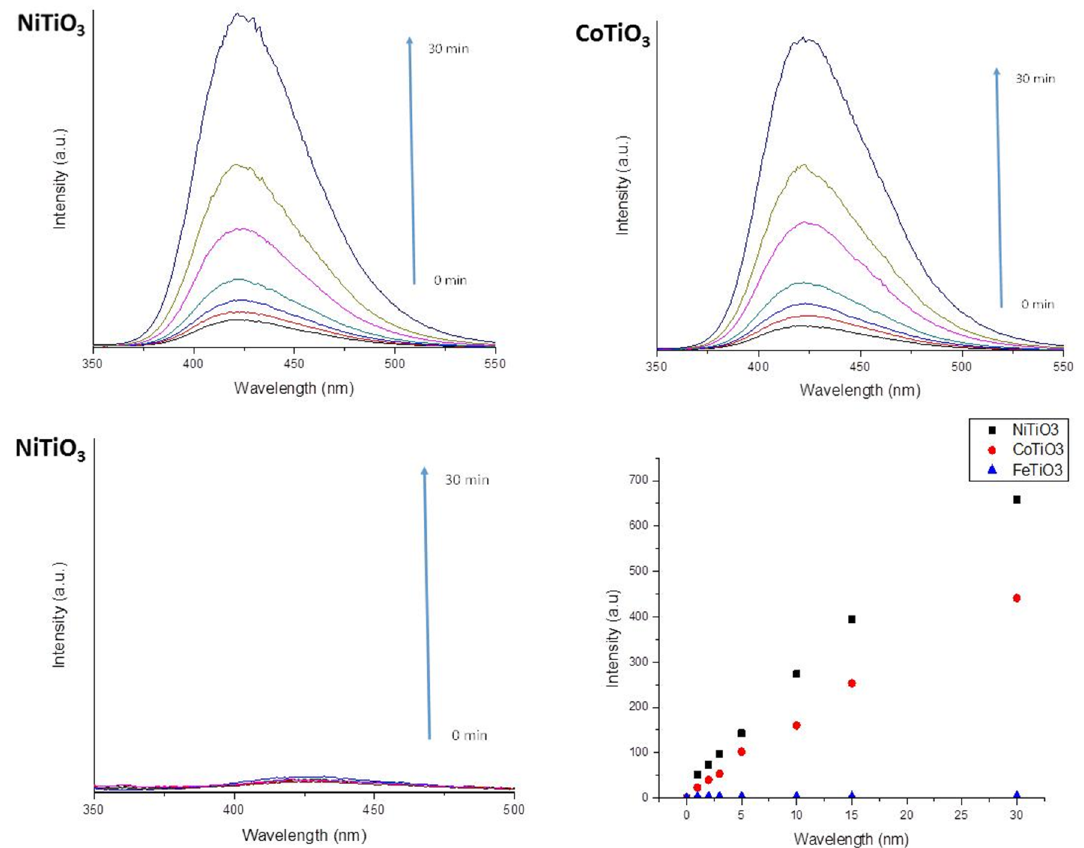
, CoTiO and FeTiO obtained by solvo-combustion method and calcined at 600 ºC/ 2h , 3 3 3